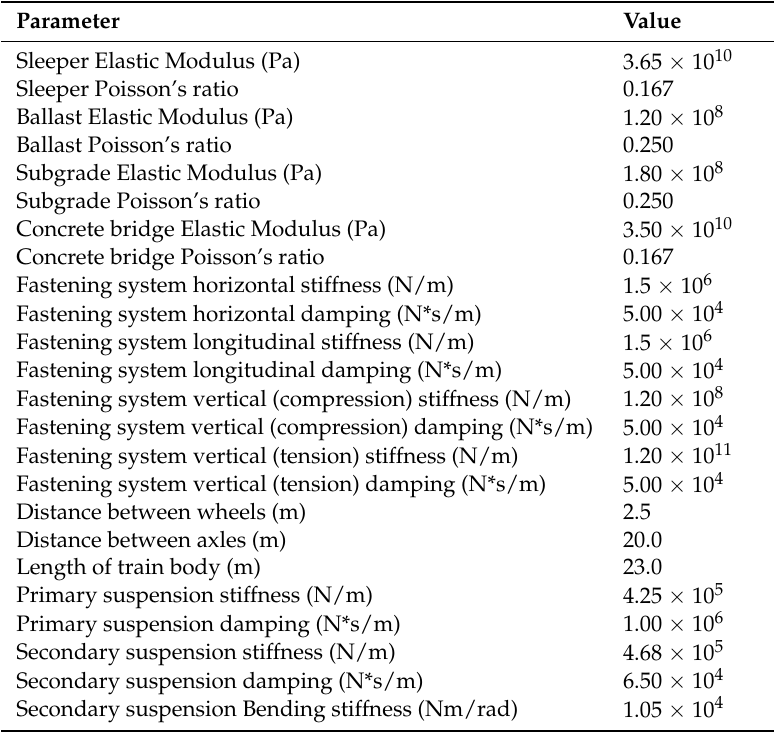
Table 2. Material properties of the track